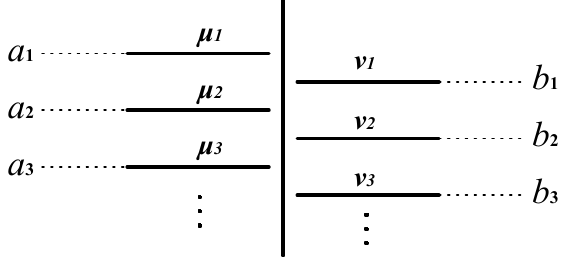
Figure 13 . A generic strip diagram. The central ( p, 1) 5-brane is simply depicted as a vertical line for simplicity. N D5-branes and N D5-branes are attached to this ( p, 1) 5-brane from the left L R and from the right,